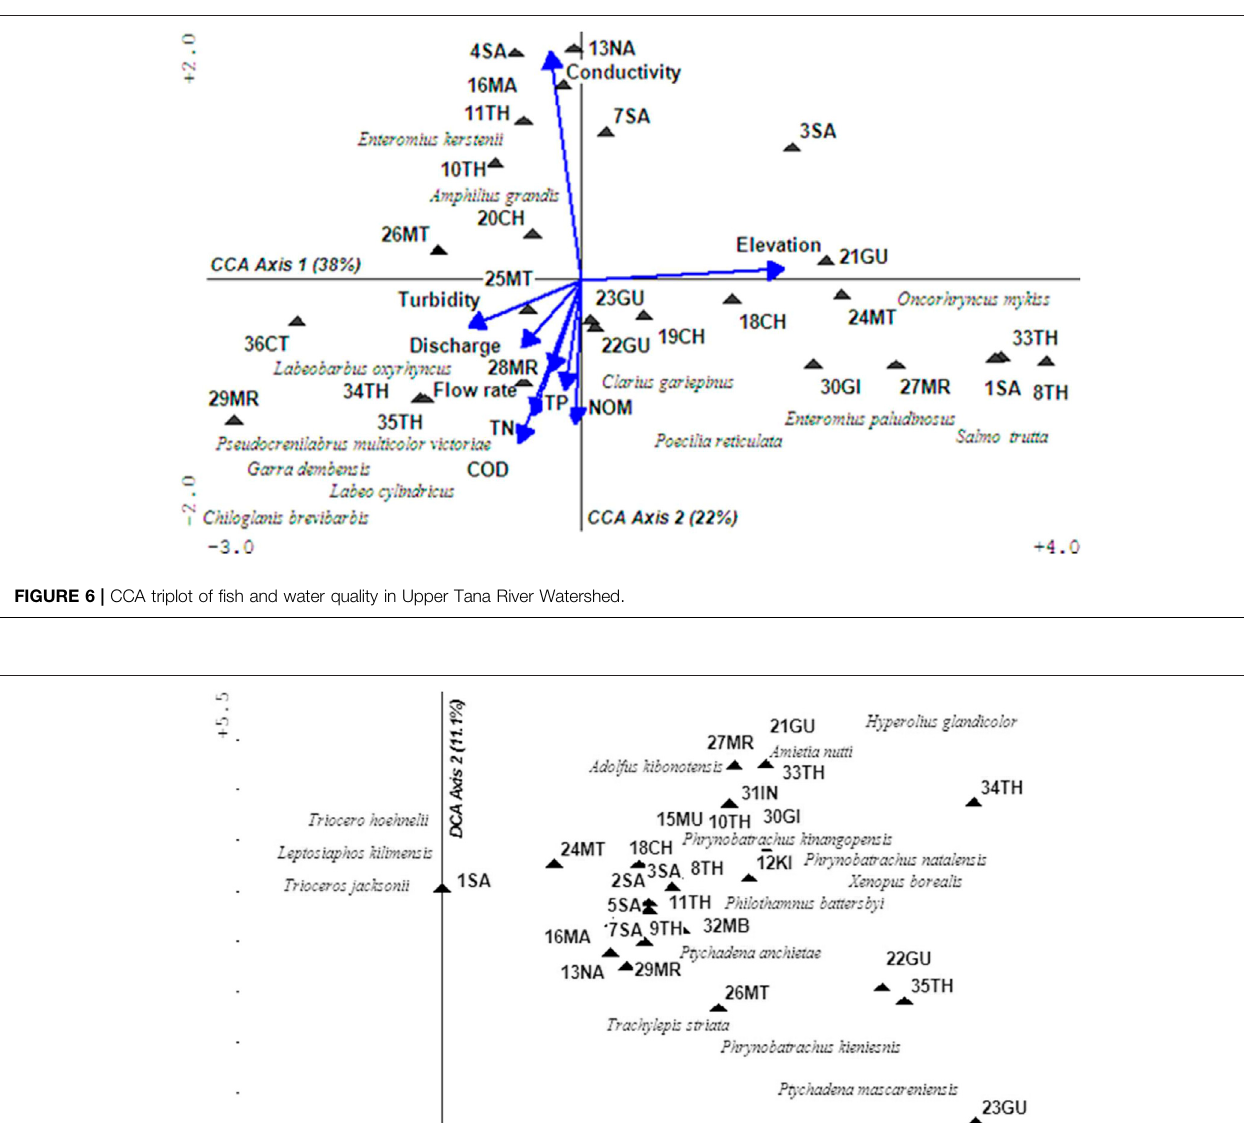
Frontiers in Environmental Science |